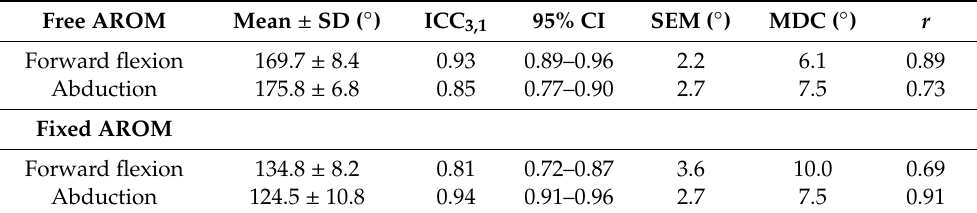
Table 2. Intra-rater reliability and Pearson’s r (HumanTrak) of rater A ( n = 50). Free